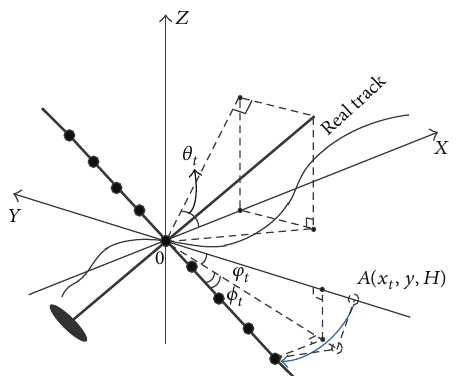
Figure 3: The geometry of MIMO SAR 3D imaging with rotational motion errors.